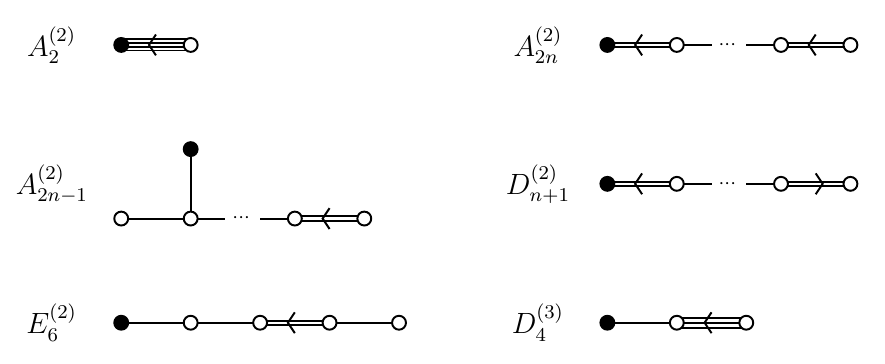
Figure 20. Dynkin diagrams of twisted affine Lie